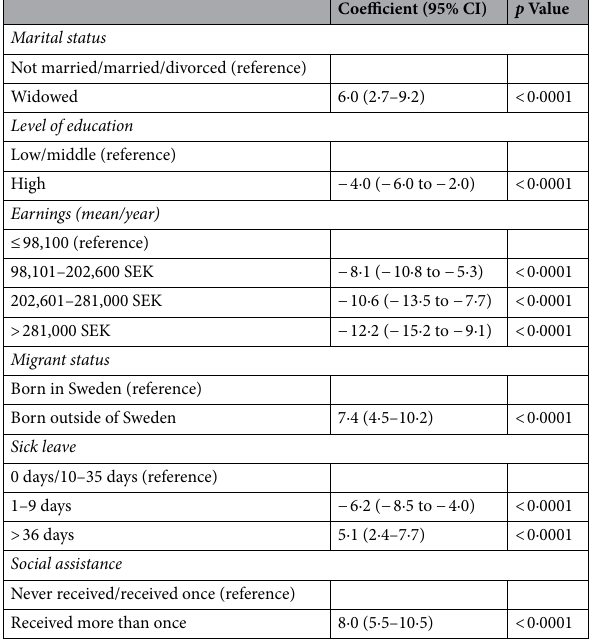
Table 2. Reduced model 3c. Multivariate linear regression analysis of QuickDASH at 12 months. All variables with p value < 0.1 in reduced model 3b are included. Excluded variables: age at surgery, sex, diabetes at surgery, manual/non-manual occupation, and unemployment. Coefficients are unstandardized. CI; confidence